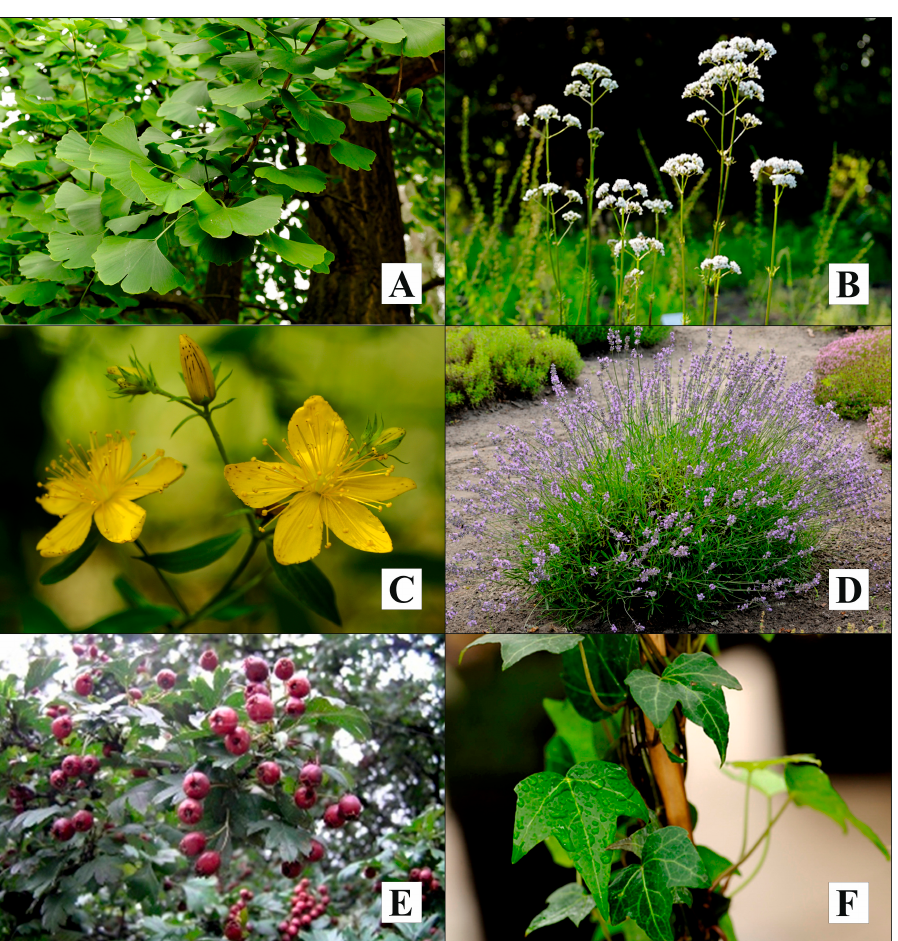
Figure 2. Chosen plants in the treatment of COVID-19 complaints (Garden of Medicinal Plants in Department of Medicinal and Cosmetic Natural Products, Poznan University of Medicinal Sciences, 33 Mazowiecka Street, 60-623 Poznan, Poland): Ginkgo biloba ( A ), Valeriana officinalis ( B ), Hypericum perforatum ( C ), Lavandula officinalis ( D ), Crataegus monogyna ( E ), Hedera helix ( F ). Ginkgo biloba leaf, in particular, has a very good pharmacological profile (Figure Its mechanism of action of increasing both serotonin and norepinephrine levels pro- 2A). vides the effectiveness of synthetic drugs while not causing the dangers they can cause